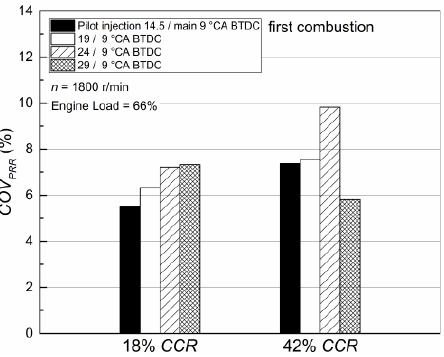
Figure 6. COV PRR of first combustion stage under different pilot injection timings.